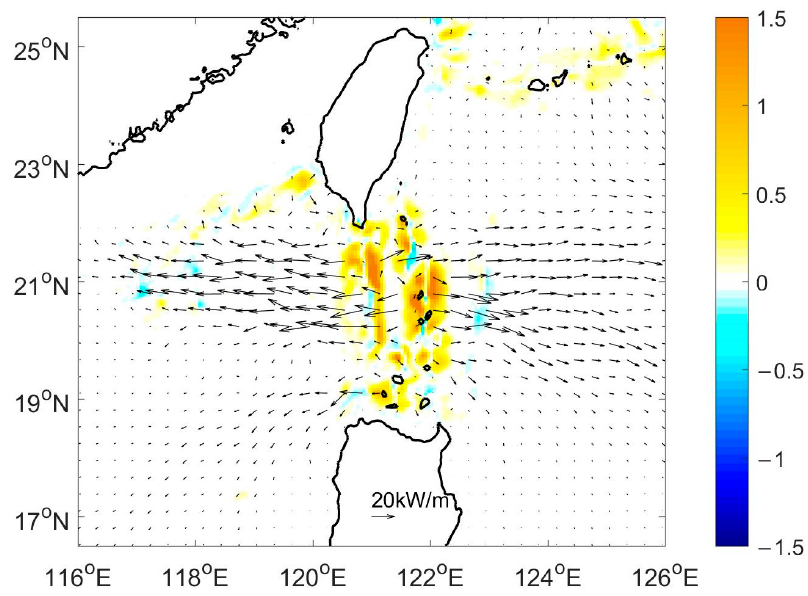
Figure 4. The M 2 baratropic-to-baroclinic conversion rates (shading, unit: W/m 2 ) and the ITs depth-integrated baroclinic energy fluxes (quiver) in the simulation domain.